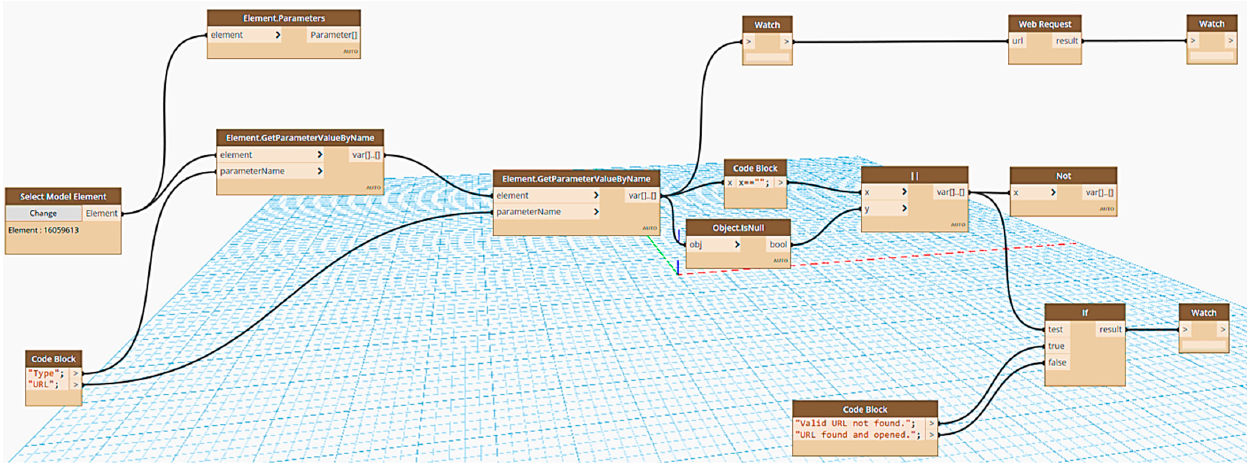
Figure 8. Implementation of the DynaWeb package in the Dynamo workplace environment.